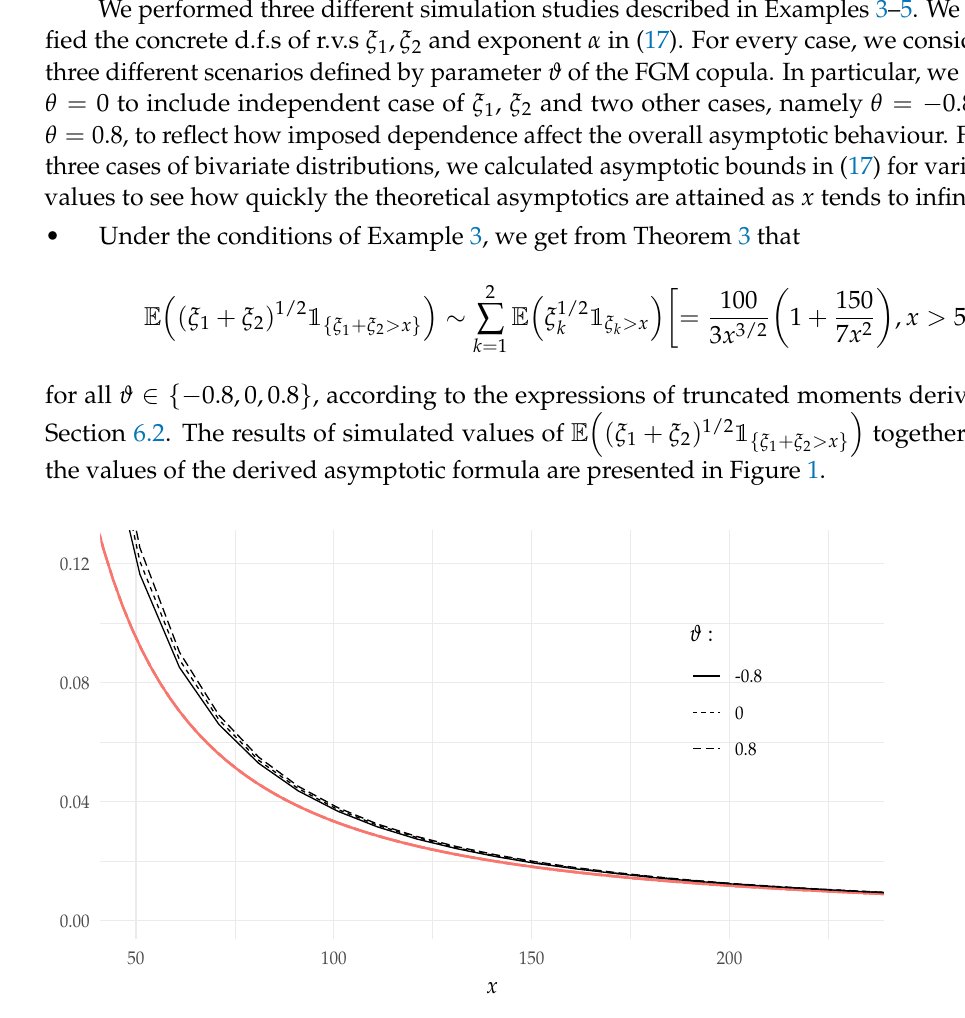
Figure 1. Simulated and asymptotic values for the truncated expectation of Example 3. Solid red line represents the exact asymptotic values of